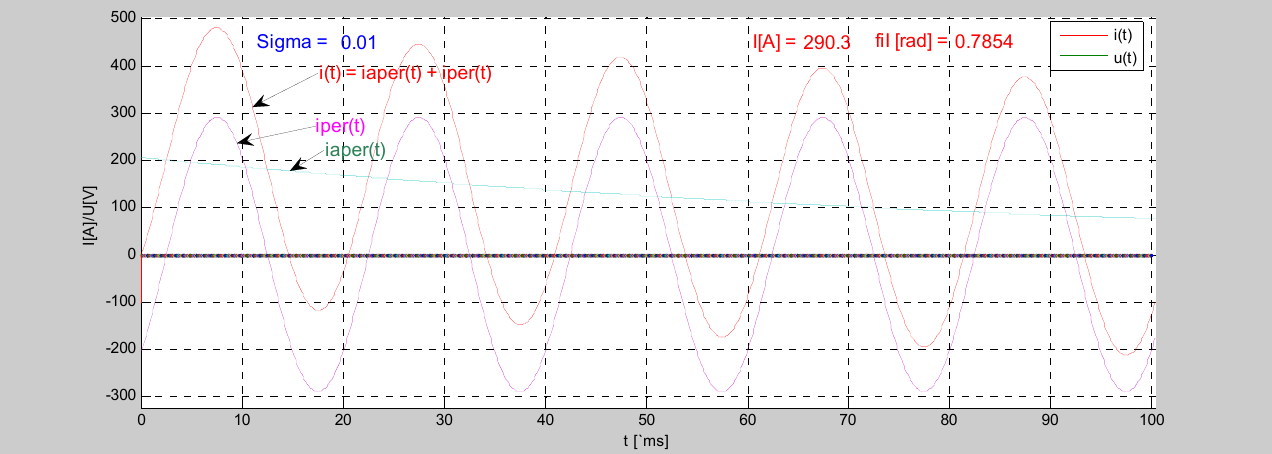
Figure 8. Components of the transient characteristic on inductive load; over time, t ∈ (0,100) ms.